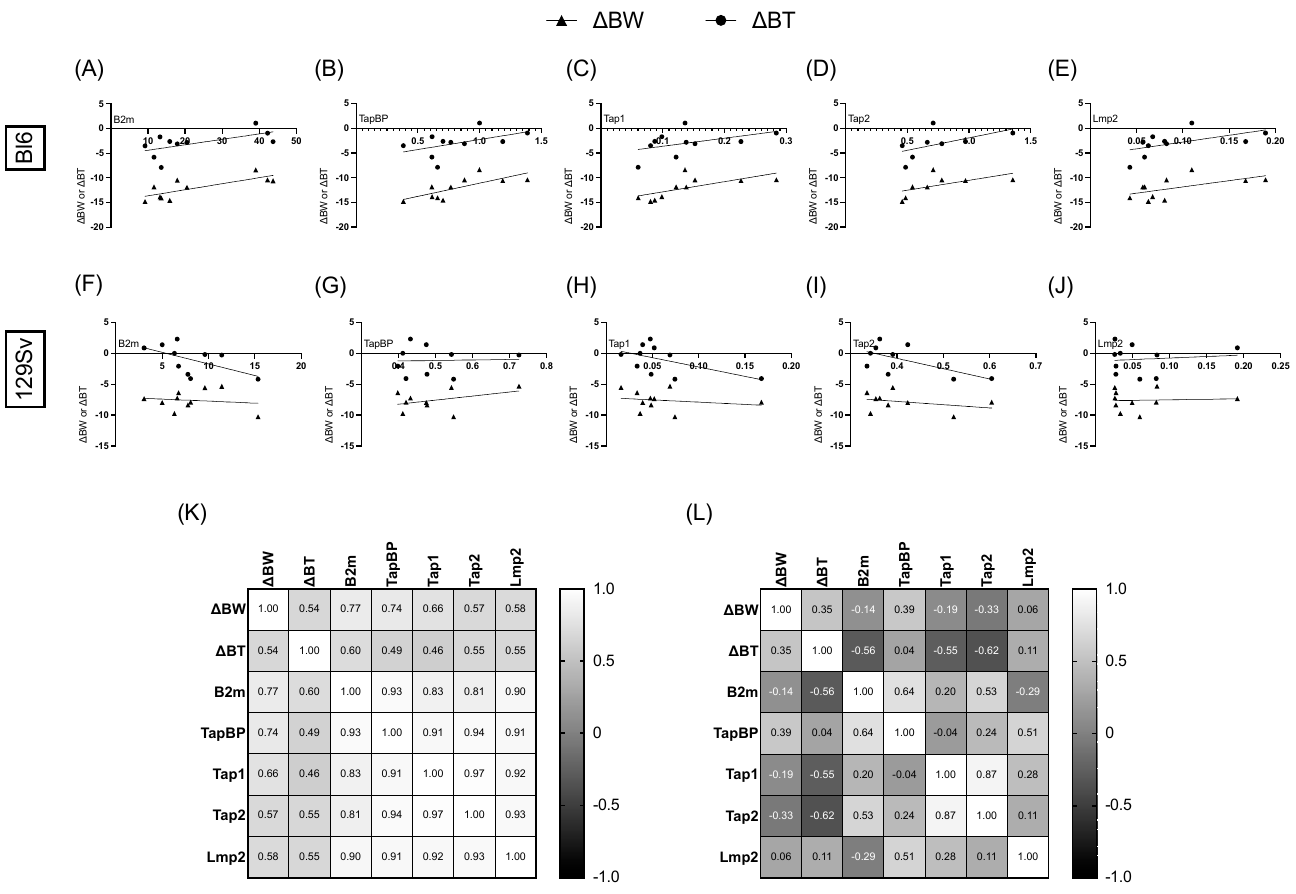
Figure 8. Correlation of MHC-I pathway gene expressions with bodyweight ( Δ BW) and temperature ( Δ BT) change in olfactory bulb. Pearson correlation of Δ BW and Δ BT with β 2m ( A ), Tapbp ( B ), Tap1 ( C ), Tap2 ( D ), and LmI ( E ) in Bl6 mice. Pearson correlation of Δ BW and Δ BT with β 2m ( F ), Tapbp ( G ), Tap1 ( H ), Tap2 ( I ), and Lmp2 ( J ) in 129Sv mice. Heatmap of Pearson correlation coefficients between Δ BW, Δ BT, and MHC-I-pathway gene expressions in Bl6 ( K ) and 129Sv ( L ) mice.